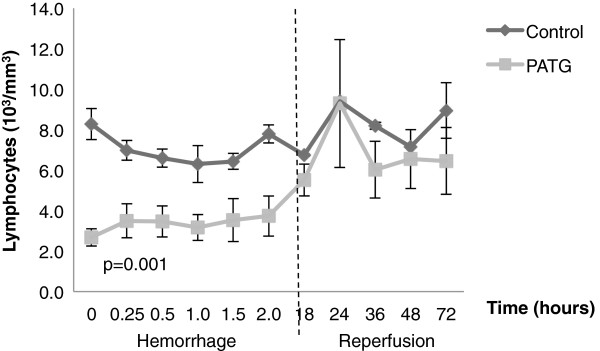
Peripheral lymphocyte counts during hemorrhage and reperfusion periods. One-way ANOVA with repeated measures design was used for statistical comparison. Error bars represent ± SEM.